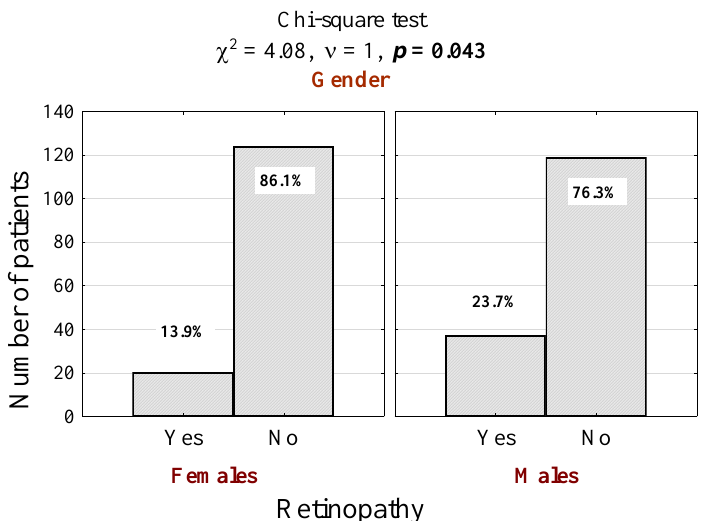
Figure 1. Number (percentage) of patients in groups differing in the presence of retinopathy and gender, and the test of independence.